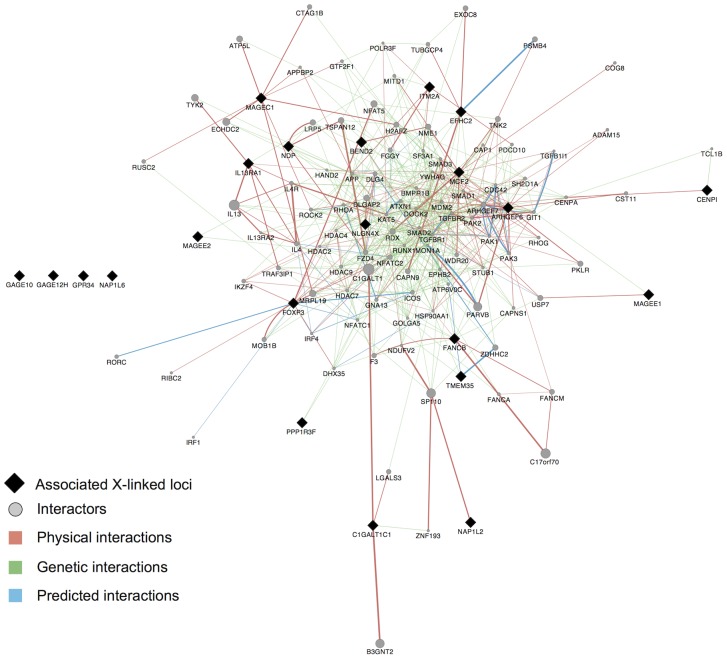
Interactome of X-linked disease risk genes.All 22 X-linked protein-coding genes that showed evidence of association and replication (Figure 1) are denoted by black diamonds and are presented together with genes that interact with them (grey circles) (Materials and Methods). Physical interactions refer to documented protein-protein interactions. Genetic interactions represent genes where perturbations to one gene affect another. Predicted interactions were obtained from orthology to interactions present in other organisms [159]. All but four of these 22 genes share interacting partners according to these known and predicted interactions. Results of a pathway analysis based on this interactome are presented in Table 5.